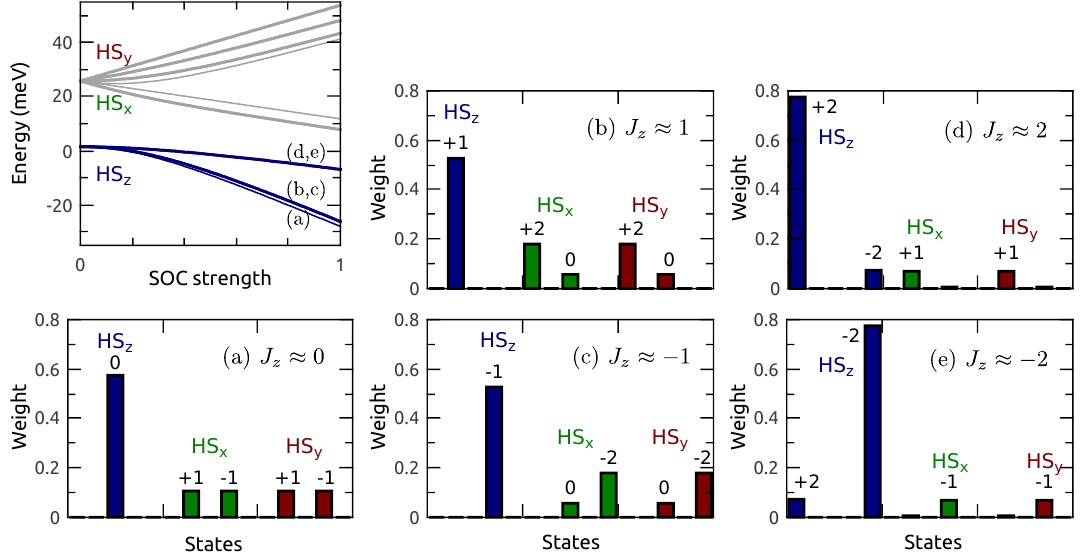
Figure 4: Splitting of atomic energies by SOC, where the maximal strength corre- sponds to ζ = 56 meV. In this limit, the structure of 5 lowest states is shown by plotting weights of the states (a)-(e). The labels and numbers on the top of color bars correspond to the orbital character and spin projection s basis ( ζ = 0),